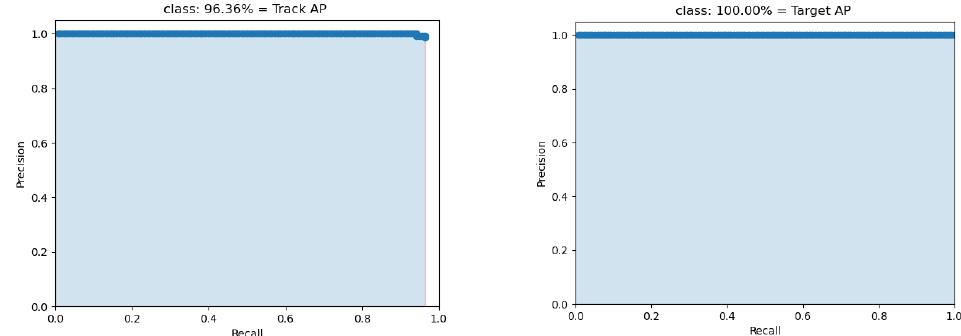
Figure 6. Precision–Recall curves for detected classes.